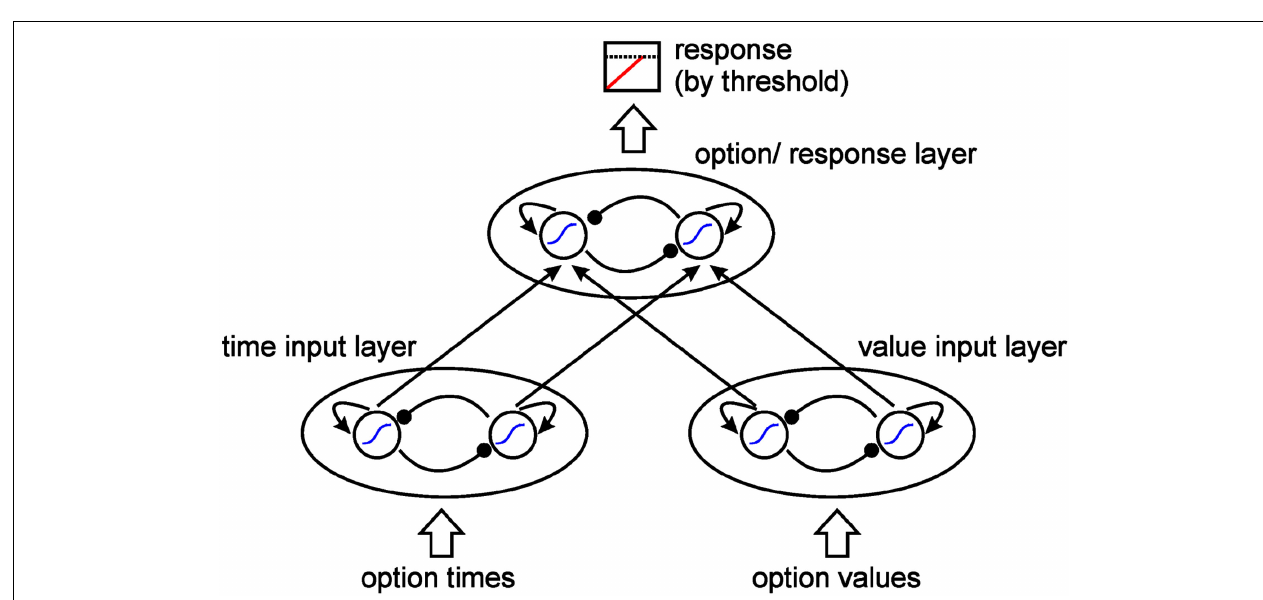
Response is elicited by reaching a response threshold. All units follow a sigmoid activation function, show recurrent excitation, and inhibit each other within each